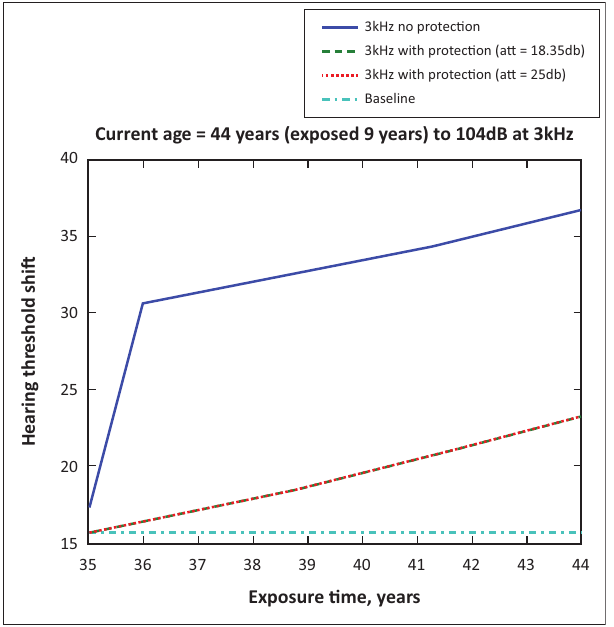
Source : Figure created using data from Moroe, N.F. (2018). Occupational noise-induced hearing loss in South African large scale mines: From policy formulation to implementation and monitoring . Doctoral thesis. Johannesburg: University of the Witwatersrand. FIGURE 3: Forty-four years old at 3000 Hz with exposure levels of 104 dB.